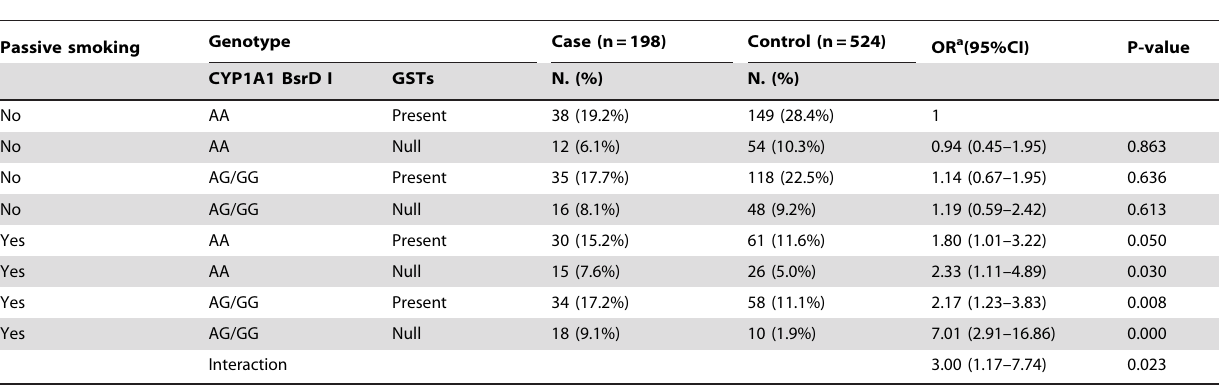
Table 5. Interaction between maternal passive smoking during pregnancy and joint genotype of CYP1A1 BsrD I and GSTs on risk of spontaneous